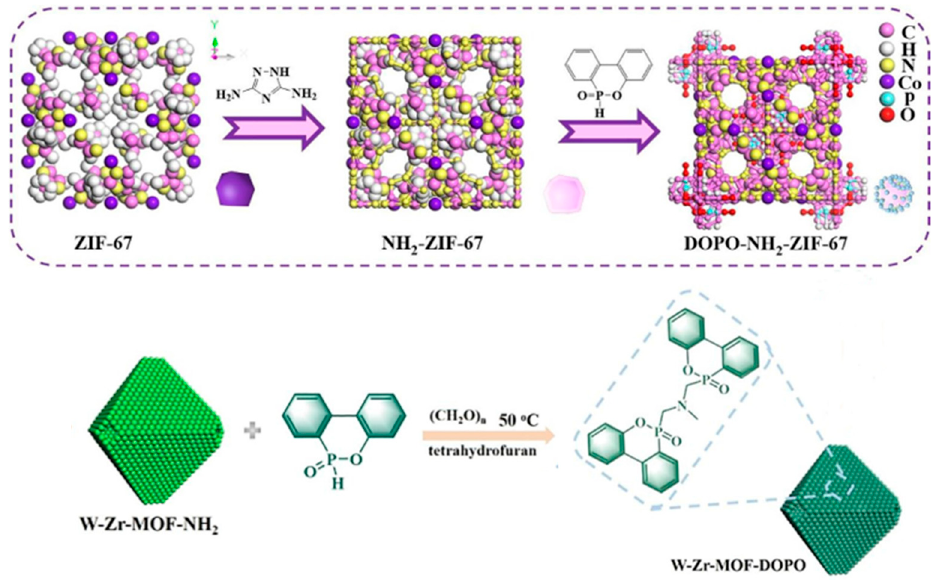
Figure 6. Schematic diagram of DOPO-NH 2 -ZIF-67 and W-Zr-MOF-DOPO structures. Reprinted with permission from Ref. [68]. Copyright 2021 Elsevier, and Ref. [72]. Copyright 2022 Elsevier.